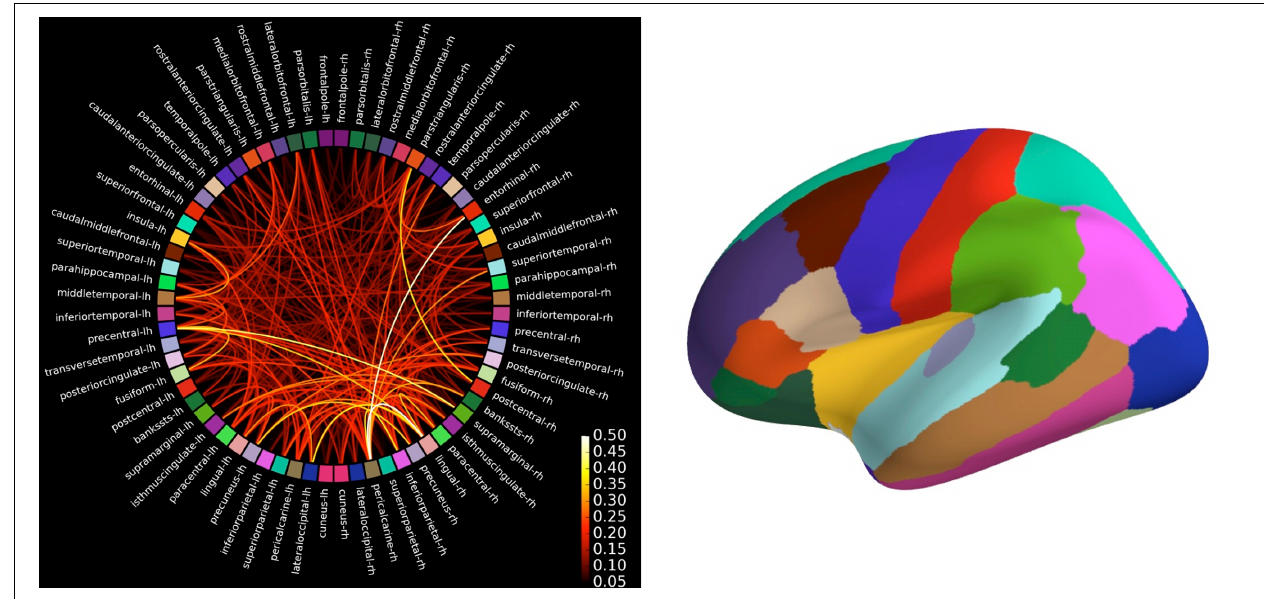
FIGURE 9 | Connectivity between brain regions of interests, also called labels, extracted from the automatic FreeSurfer parcellation visualized using plot_connectivity_circle . The image of the right presents